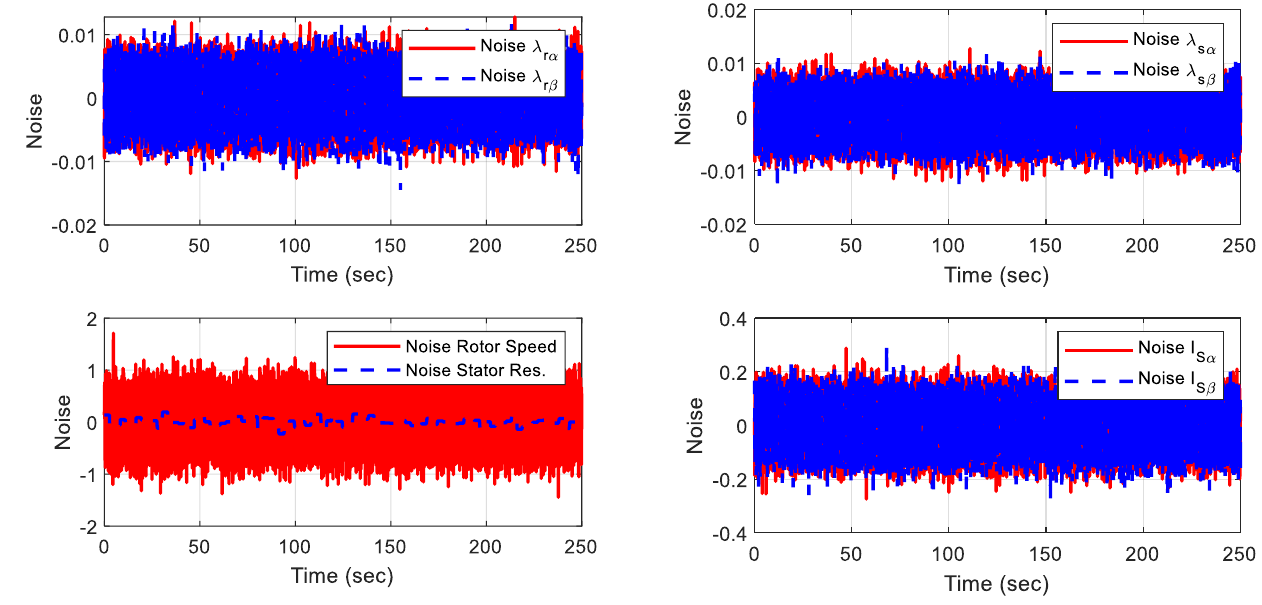
Figure 3. Imposed noise for rotor and stator fluxes, stator currents, rotor speed, and stator resistance.